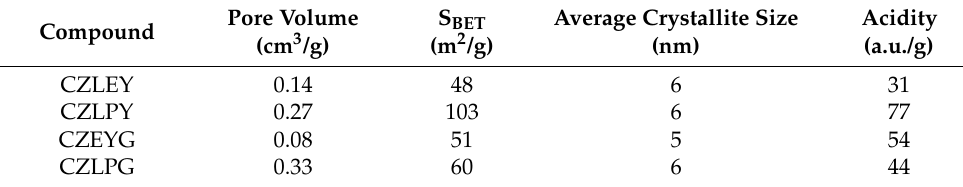
Table 2. Physicochemical characteristics of the investigated